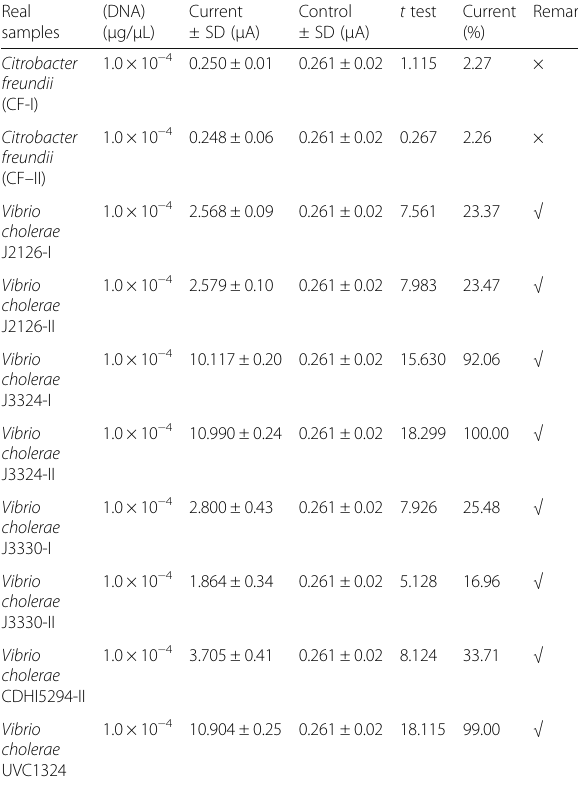
Table 3 Selectivity of DNA biosensor towards the detection of V. cholerae DNA Real samples